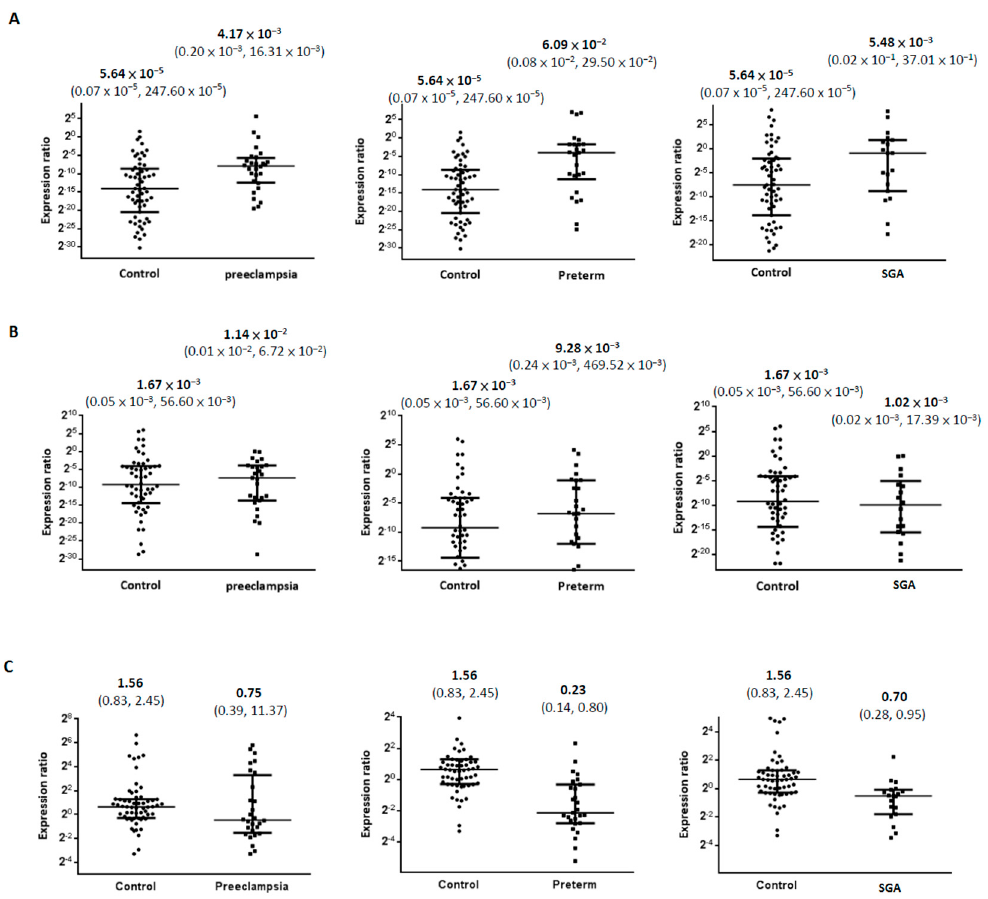
Figure 2. Comparison of miR-582-3p expression levels between compromised and healthy pregnancies in three gestational specimens. miR-582-3p expression levels [median (interquartile range)] of maternal plasma ( A ) are significantly higher in groups of preeclampsia and preterm delivery ( p values < 0.05). Although miR-582-3p expression levels in fetal cord plasma ( B ) are not significantly different, its expression level in the placenta ( C ) is lower in the groups of preterm delivery and SGA than in the healthy controls ( p values < 0.05).